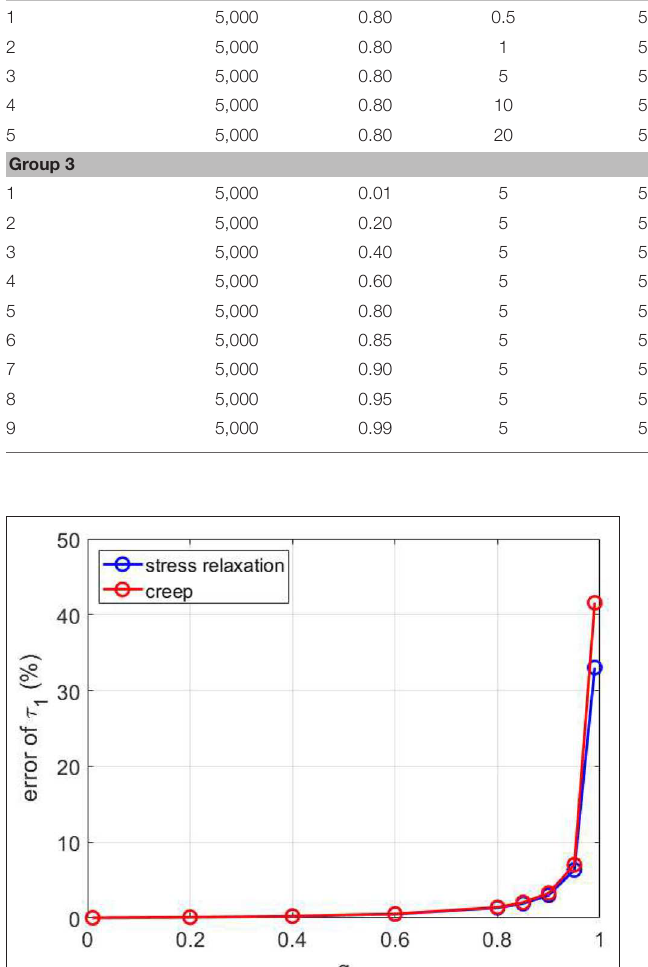
elasticity increases, and ratio of viscous fluids to solids decreases with increasing particle